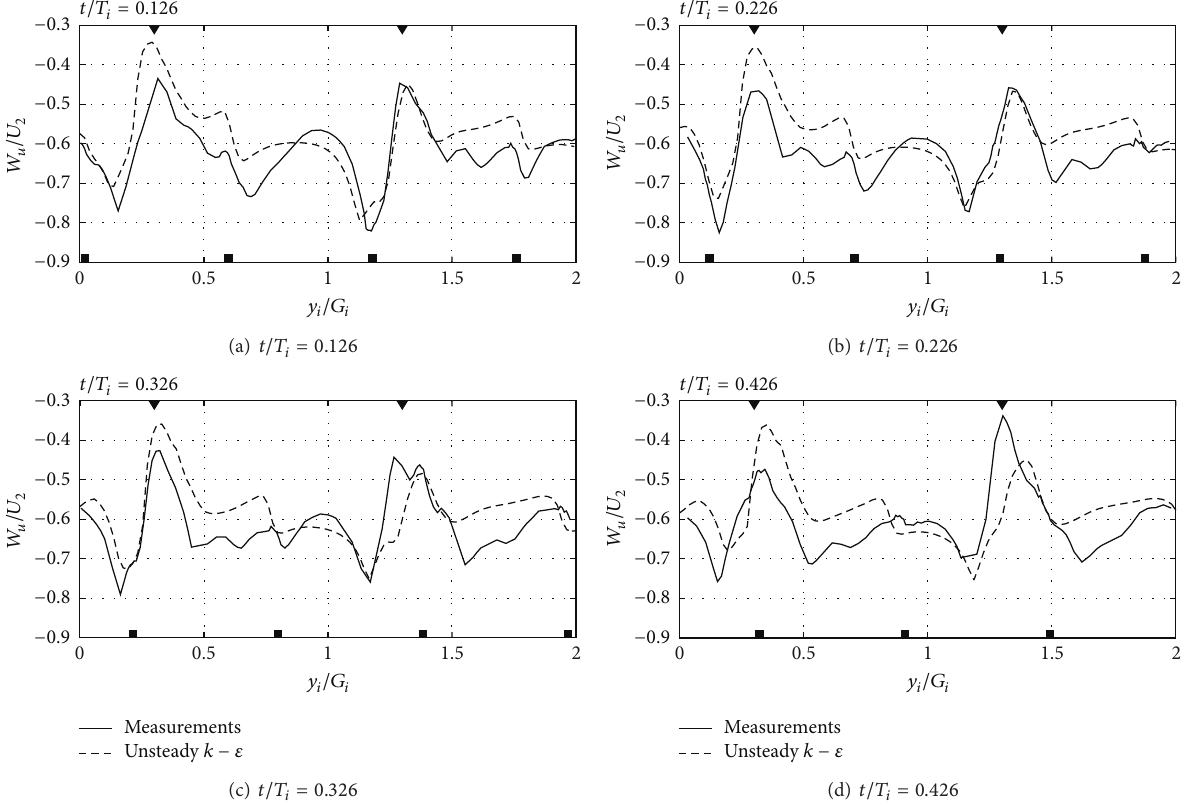
Figure 7: Tangential velocity in the radial gap ( 𝑅/𝑅 2 = 1.02 ) at mid-span for the unsteady simulation using the 𝑘 − 𝜀 turbulence model.